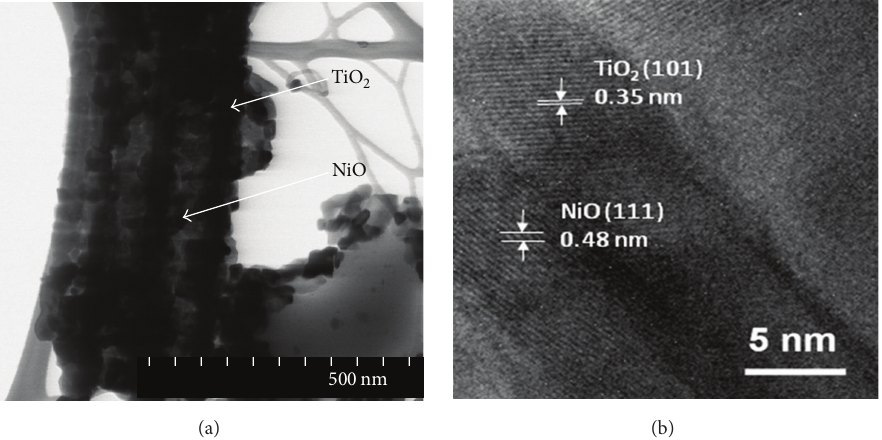
Figure 2: (a) STEM image and (b) HRTEM image of NiO/TNTs (0.5M).